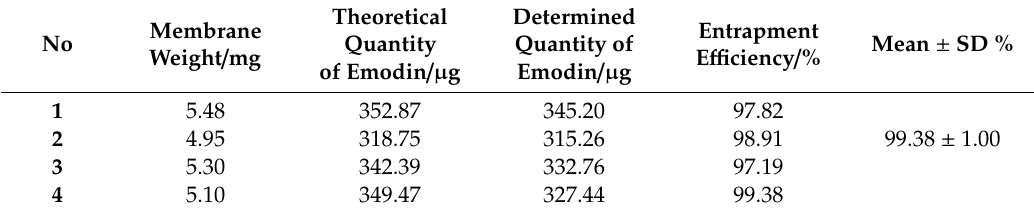
Table 1. Entrapment efficiency of emodin in nanofiber membrane (n = 4).